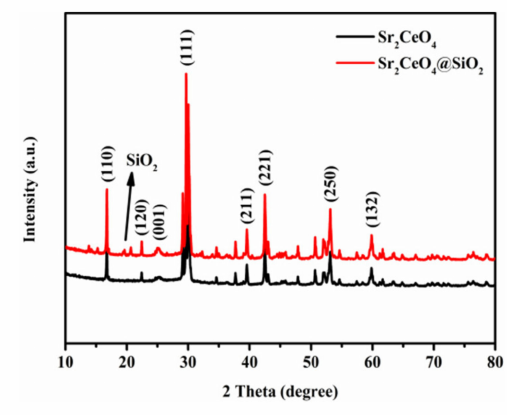
Figure 2. XRD patterns of Sr 2 CeO 4 and Sr 2 CeO 4 @SiO 2 .